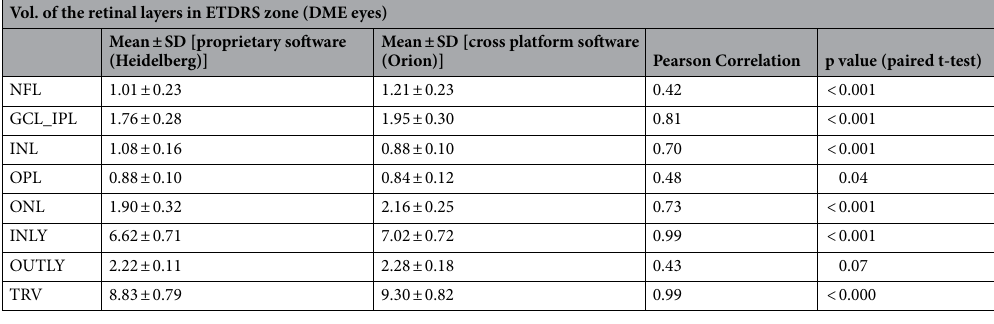
Table 5. Layer volume data in eyes with Diabetic Macular Edema (DME) from the proprietary and the cross- platform